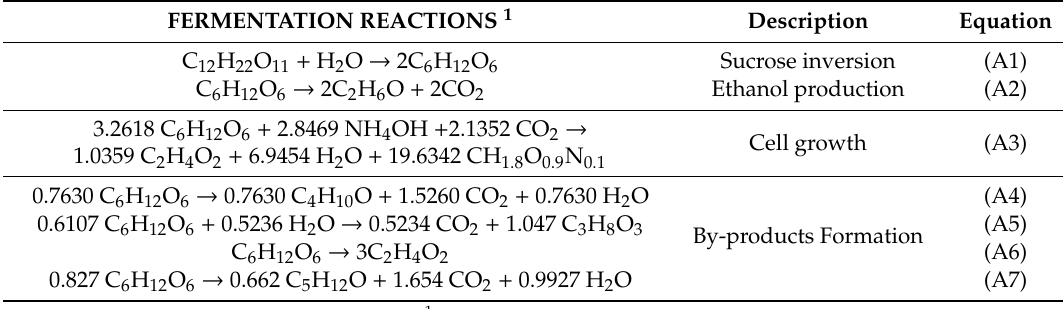
Table A5. Fermentation